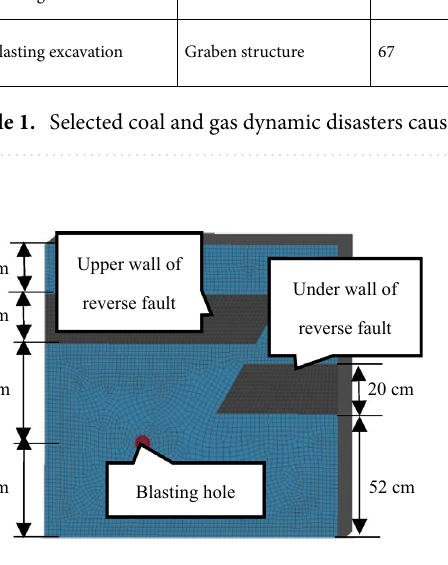
Figure 1. Three-dimensional (3-D) numerical blasting model used in this analysis.